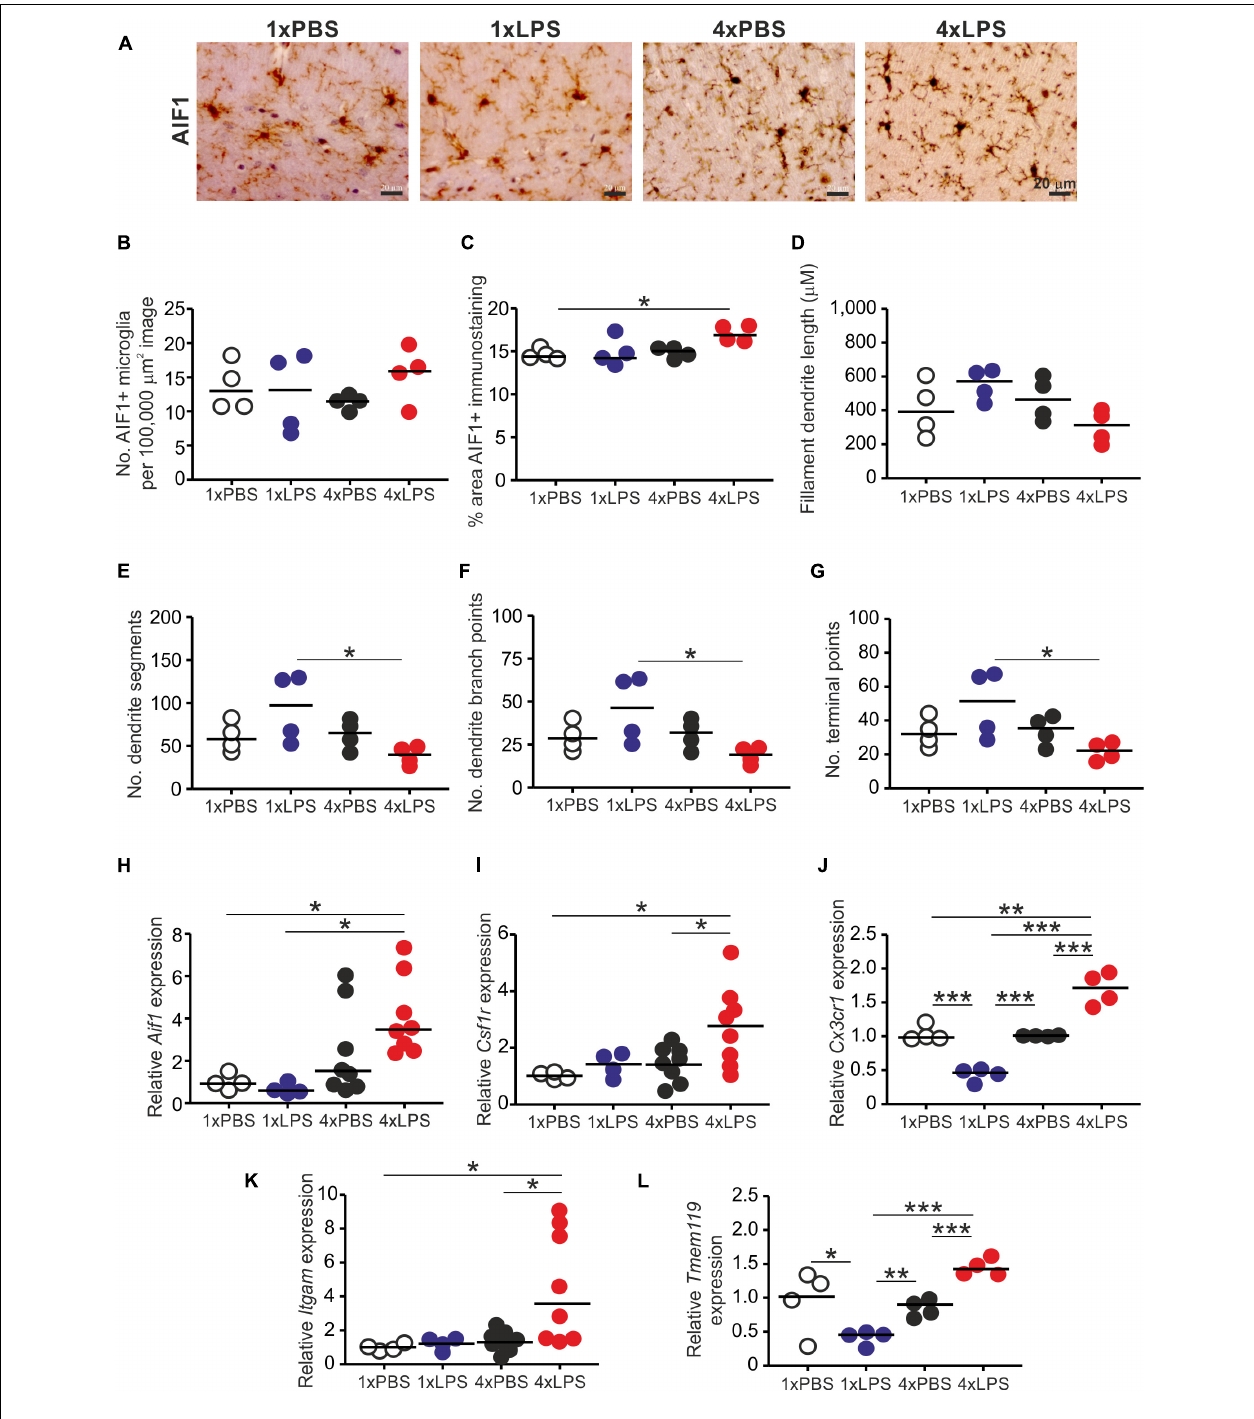
FIGURE 3 | Effect of systemic LPS treatment on microglia. Mice were given a single (1x) four (4x) daily IP injections with either LPS or PBS (control) and brains collected 3 h after the final injection. (A) Representative immunostaining of AIF1 + microglia (brown) in the CA1 region of the hippocampus striatum radiatum of each mouse. Scale bar 20 µ m. (B) Relative abundance of AIF1+ microglia in 100,000 µ m 2 images of the CA1 region of the hippocampus striatum radiatum of mice from each group. (C) Comparison of the magnitude of the AIF1+ immunostaining in the CA1 region of the hippocampus striatum radiatum of mice from each group. Assessment of AIF1+ microglia morphology in the CA1 region of the hippocampus striatum radiatum of mice from each group: (D) , mean filament dendrite length; (E) , mean number of dendrite segments; (F) , mean number of dendrite branch points; (G) , mean number of terminal points. (H–L) Relative expression level of Aif1 , Csf1r , Cx3cr1 , Itgam, and Tmem119 mRNA in half brains from each mouse from each group. Gene expression data are normalized so that the mean level in the 1xPBS controls was 1.0. N = 4–8 mice/group; horizontal bar in histograms, median. * P < 0.05; ** P < 0.01; *** P < 0.001.